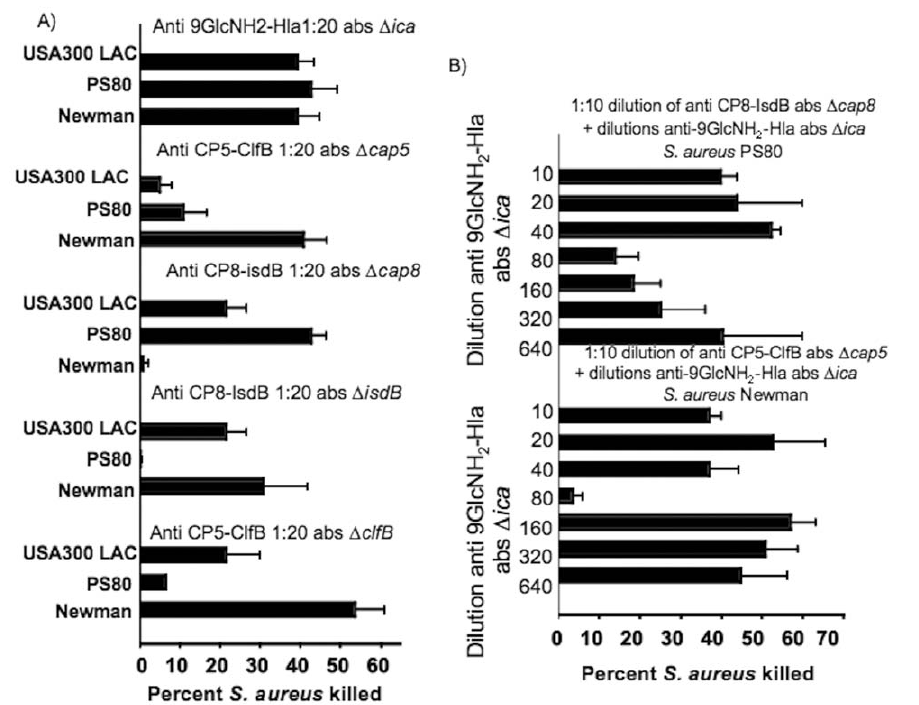
Figure 3. Opsonic killing activity in rabbit sera raised to 9GlcNH 2 -Hla, CP5-ClfB and CP8-IsdB conjugate vaccines. (A) Killing at a serum dilution of 1:20 of S. aureus strains USA 300 LAC, PS80 and Newman with antisera raised to 9GlcNH 2 -Hla, CP5-ClfB and CP8-IsdB. Sera were absorbed for antigenic specificity as follows: antisera to CP8-IsdB were absorbed with strain Newman D isdB grown to stationary phase in RPMI medium with 1% casamino acids to make the serum specific to IsdB; antisera to CP5-ClfB were absorbed with strain Newman D clfB grown to log phase in CSB to make the serum specific to ClfB. (B). Opsonic killing of S. aureus strains PS80 and Newman when one antiserum was held constant (CP5-ClfB or CP8-IsdB) and the second one (9GlcNH 2 -Hla) diluted as indicated. Sera were made antigen-specific by absorption as indicated on figure. Bars represent means of triplicate samples, and the percent S. aureus killed was compared to normal rabbit serum. Controls lacking complement or PMN had , 10% OPKA (not